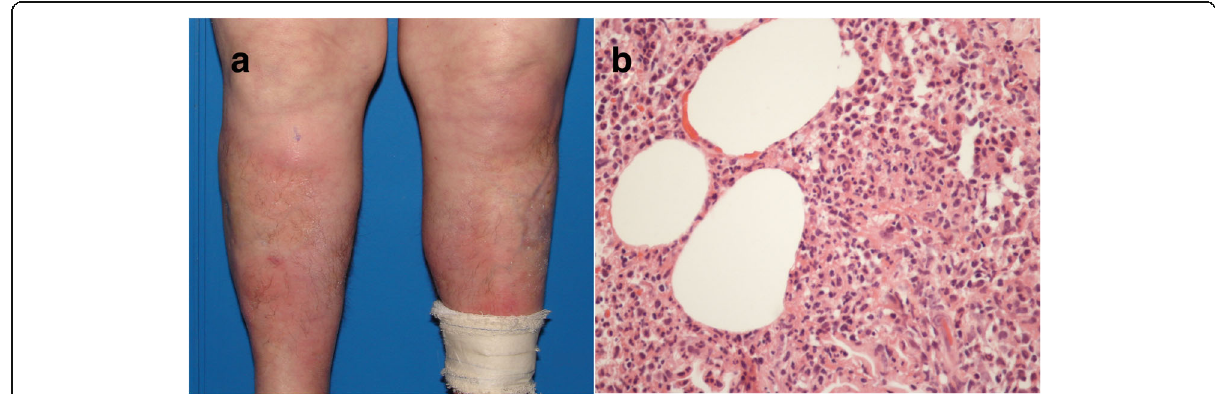
Fig. 7 Neutrophilic lobular panniculitis associated with rheumatoid arthritis. a Erythematous nodules on the anterior aspect of the legs. b Necrosis of adipocytes and intense infiltrate composed of neutrophils and histiocytes, in the lobules of the hypodermis . H&E,